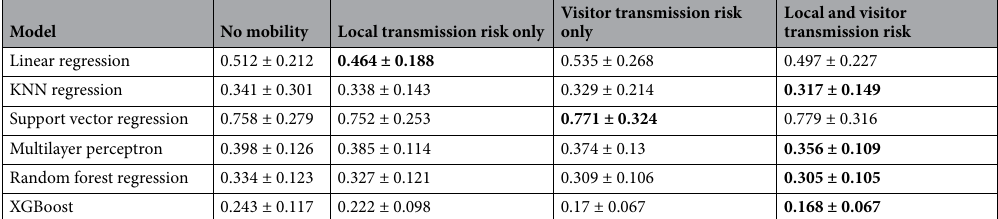
Table 1. Comparison of MAPE to forecast the number of cases with and without visitor transmission risk for various machine learning models. Best scenario for each machine learning approach is highlighted in [bold].